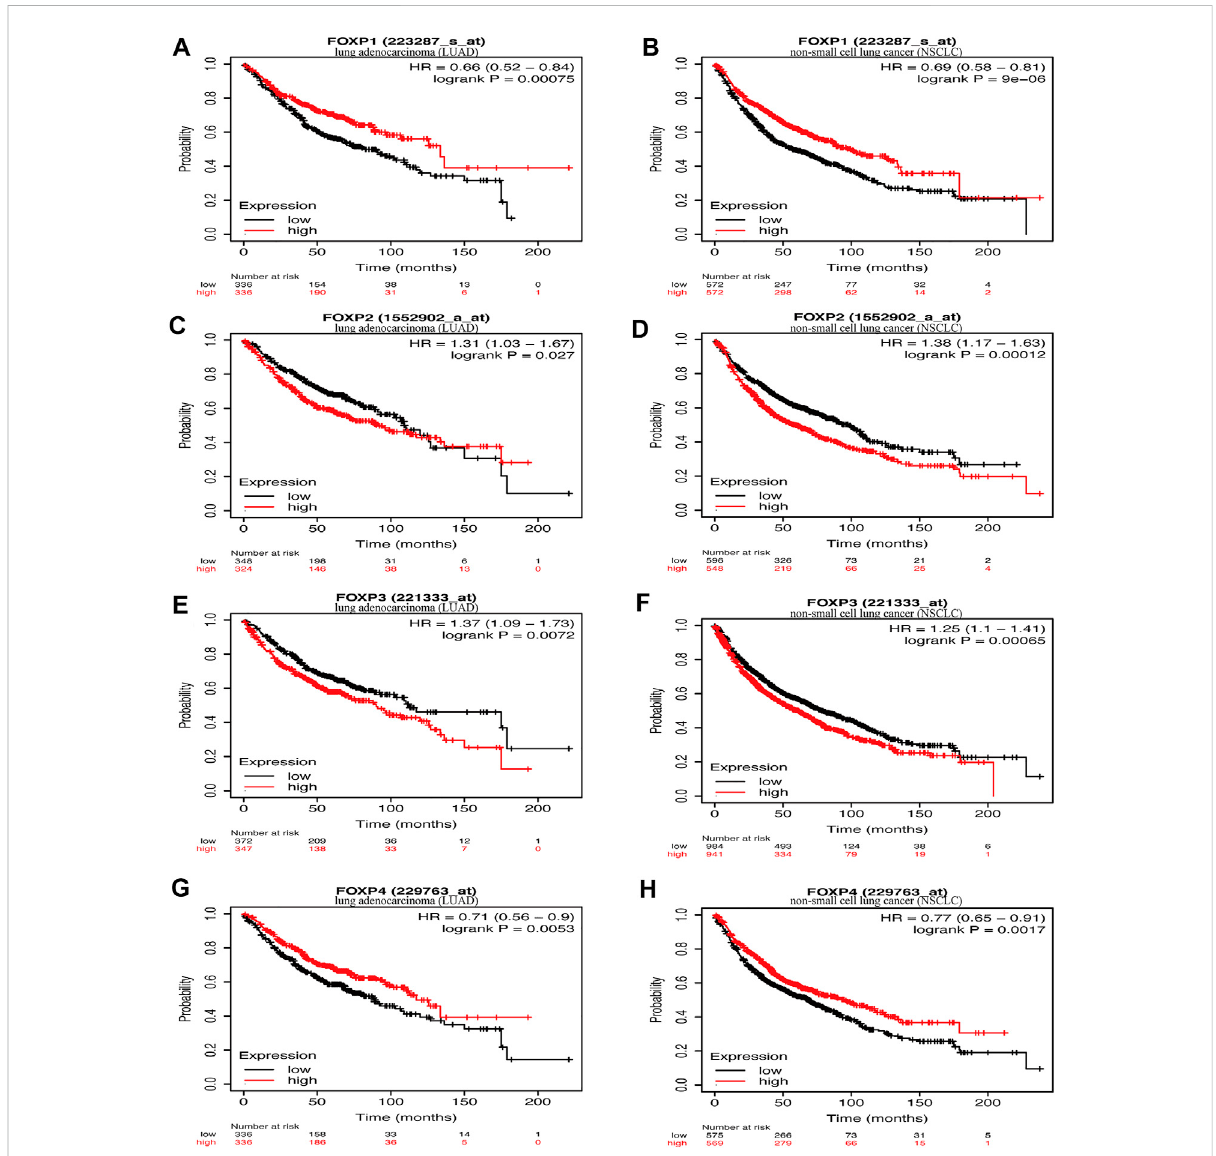
FIGURE 4 The relationship between the expression of FOXP family and survival. (A) The survival curves re fl ected the relationship between the patients ’ overall survival (OS) rate and the corresponding gene expression levels of FOXP1 in LUAD. (B) he survival curves re fl ected the relationship between the patients ’ overall survival (OS) rate and the corresponding gene expression levels of FOXP1 in NSCLC. (C) The survival curves re fl ected the relationship between the patients ’ overall survival (OS) rate and the corresponding gene expression levels of FOXP2 in LUAD. (D) The survival curvesre fl ectedtherelationshipbetweenthepatients ’ overallsurvival(OS)rateandthecorrespondinggeneexpressionlevelsofFOXP2inNSCLC. (E) The survival curves re fl ected the relationship between the patients ’ overall survival (OS) rate and the corresponding gene expression levels of FOXP3 in LUAD. (F) The survival curves re fl ected the relationship between the patients ’ overall survival (OS) rate and the corresponding gene expression levels of FOXP3 in NSCLC. (G) The survival curves re fl ected the relationship between the patients ’ overall survival (OS) rate and the correspondinggene expression levels ofFOXP4inLUAD. (H) The survivalcurves re fl ected therelationship betweenthepatients ’ overall survival(OS) rate and the corresponding gene expression levels of FOXP3 in